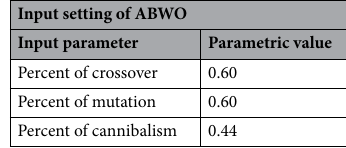
Table 1. Parameter setting of